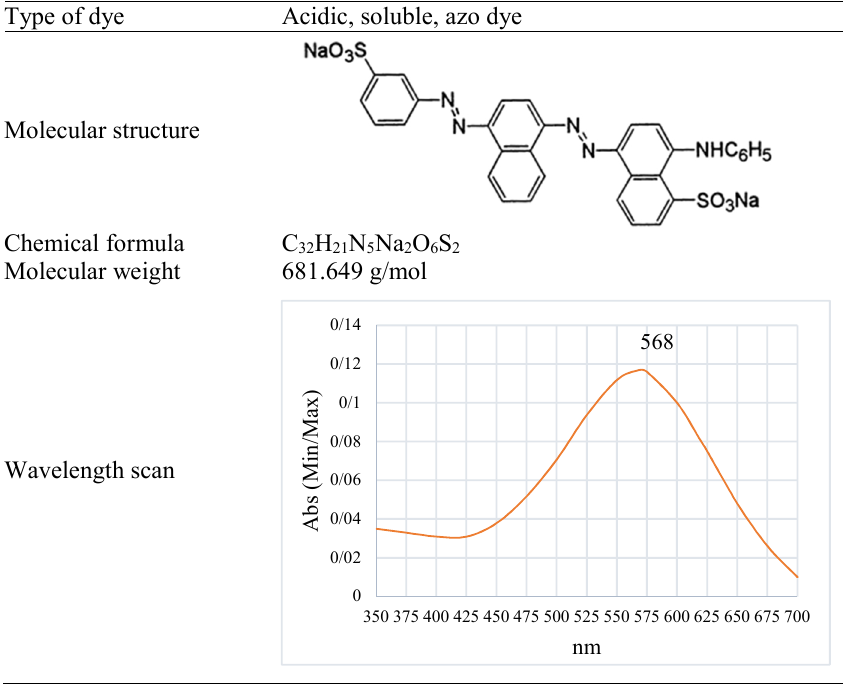
Table 2. Properties of acid blue 113 dye Type of